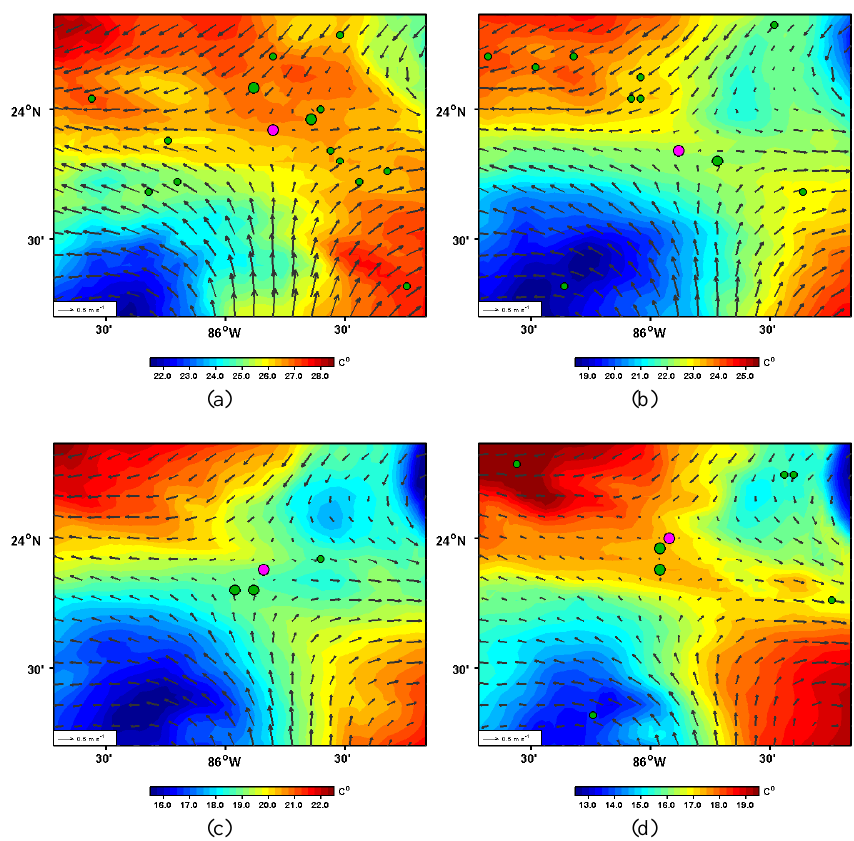
Fig. 7. Plots of the contours and saddle points (green bullets) of the temperature field, together with the velocity field and the stagnation points (magenta bullets) for 10 June 2010 at depths (a) 50, (b) 100, (c) 150, and (d) 200m. Saddle points further than 20km from the stagnation points are marked with smaller symbols and do not appear in Fig.